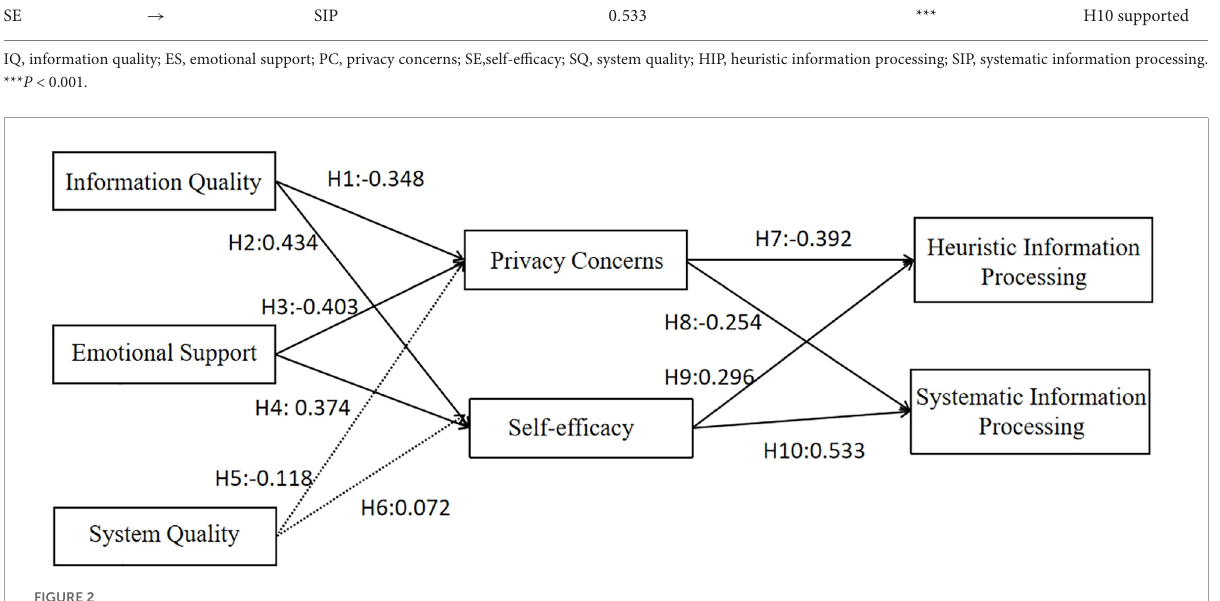
FIGURE2 Research model of hypothesis